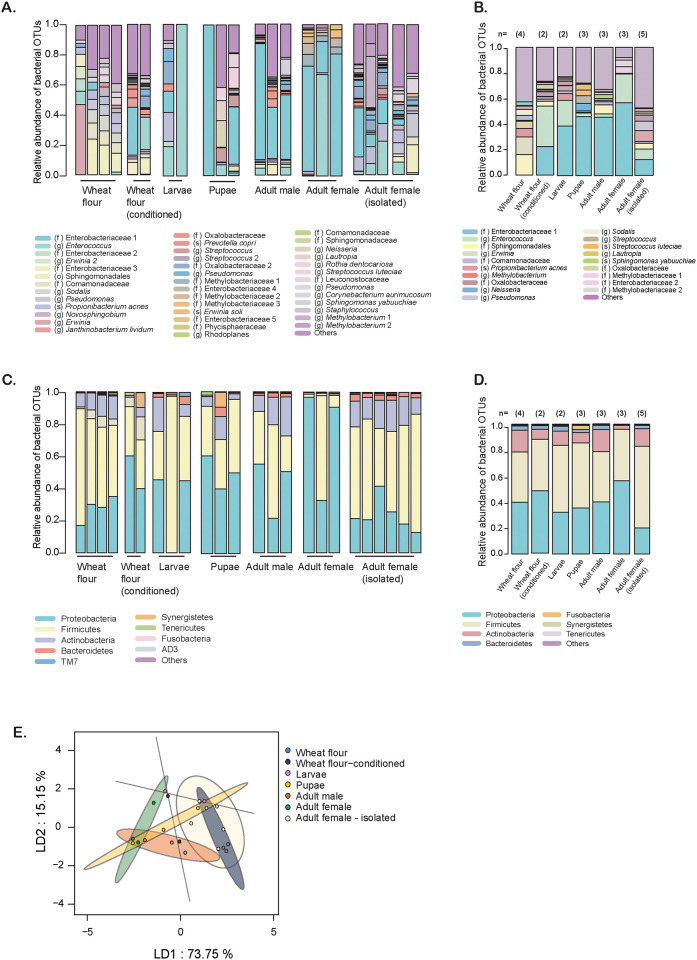
Microbiome of wheat flour and beetles reared in wheat flour.(A–D) Stacked bar plots show the relative abundance of the 5 most abundant bacterial OTUs, classified to (A, B) the lowest possible taxonomic level (see color key; o = order, f = family, g = genus, s = species) or (C, D) phylum. Panels A and C show data for individual samples of flour and beetles at various life stages; panels B and D show average relative abundance across replicates of each group (sample size is noted above each bar). In the key, numbers after each name distinguish OTUs with the same taxonomic classification (with 97% sequence identity). (E) Linear Discriminant (LD) analysis of the complete bacterial communities of flour and beetle samples; axis labels indicate % variation explained. For statistical analysis of full bacterial communities, see Table 1.